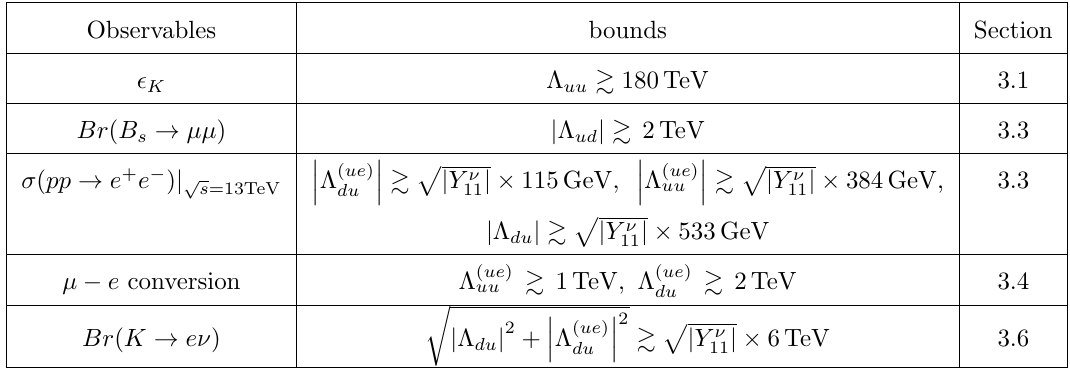
Table 6 . We summarize bounds from processes considered in this